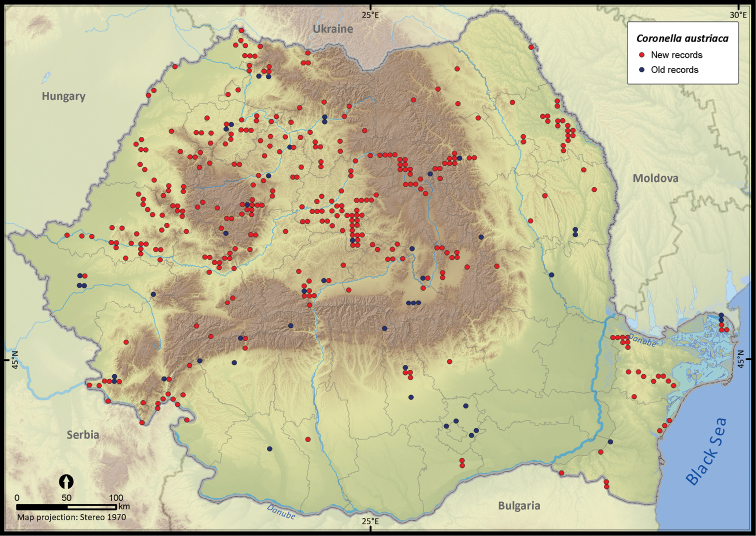
Coronella austriaca.